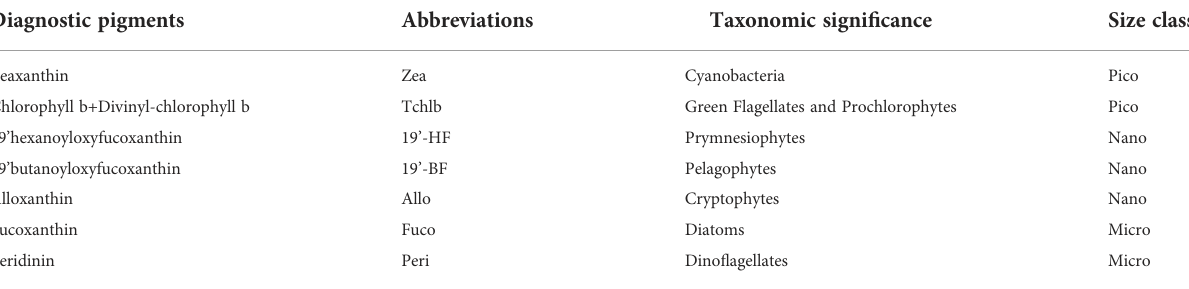
TABLE 2 Major biomarker pigments used in this study with their abbreviation, taxonomic signi fi cance and associated size class (Vidussi et al., 2001). Diagnostic pigments